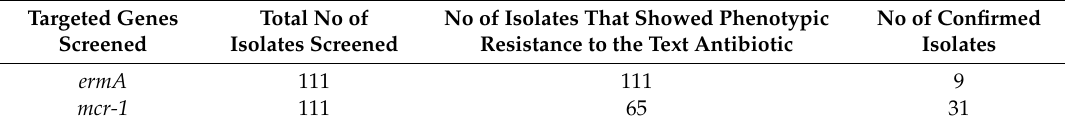
Table 4. Numbers of confirmed E. coli isolates resistant to ermA and mcr-1